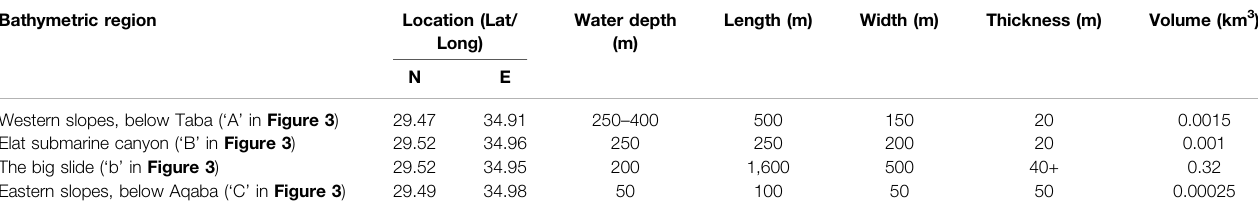
TABLE 2 | Characteristics of potential tsunamigenic submarine landslides in the head of the Gulf of Elat – Aqaba (HGEA). Bathymetric region Location (Lat/